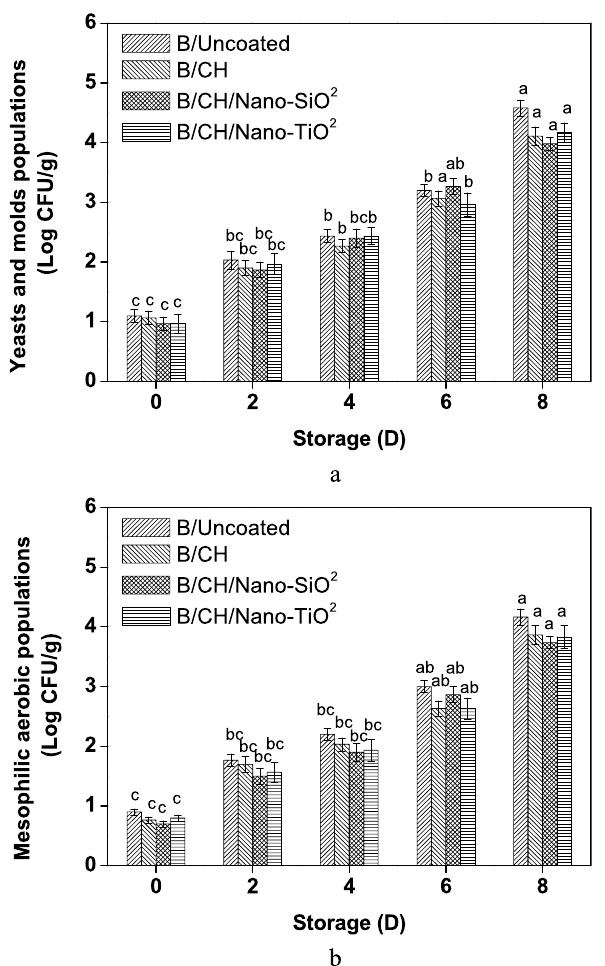
Figure 6. Microbial population measurements on coated on